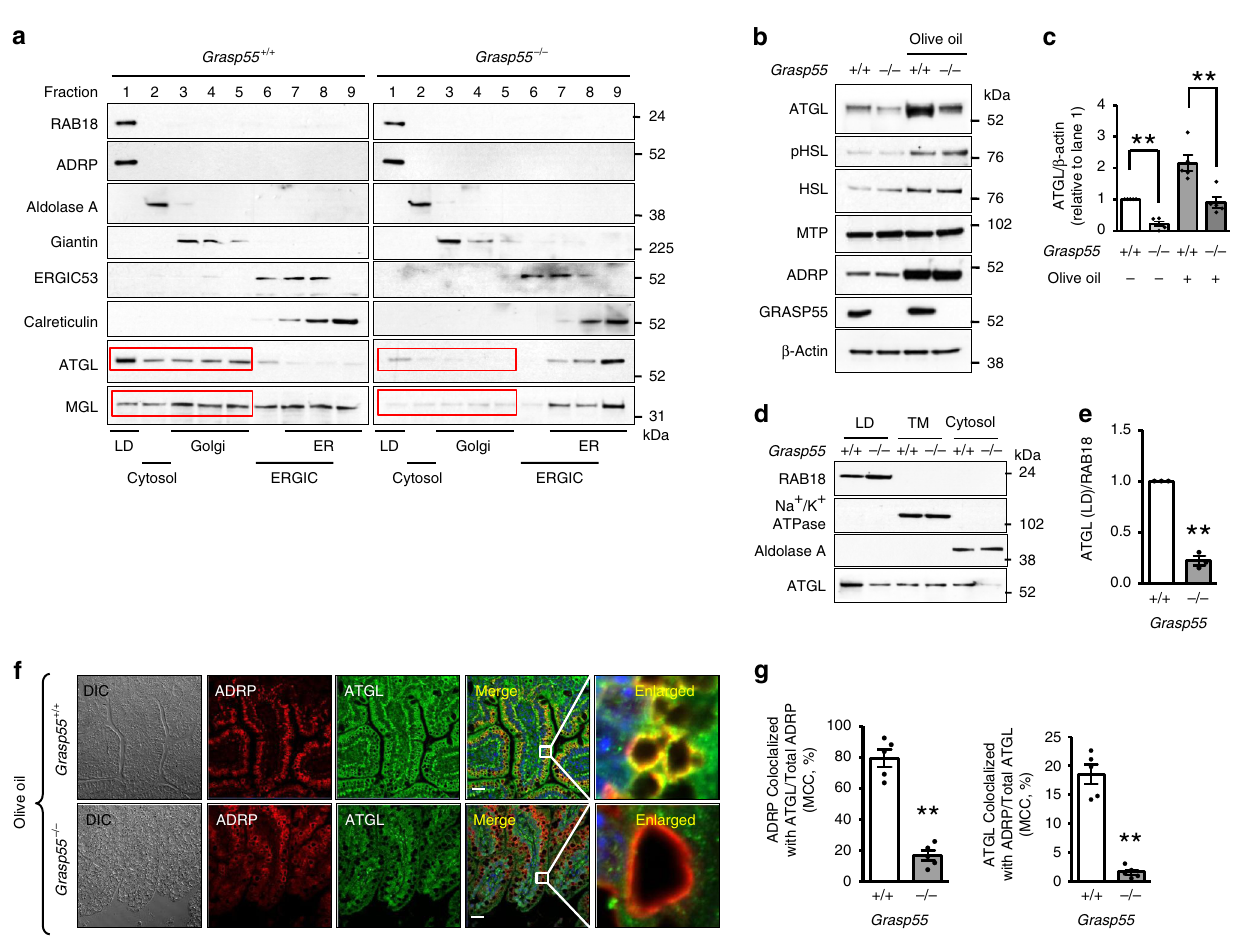
Fig. 5 GRASP55 participates in the Golgi localization and LD targeting of ATGL and MGL. a Subcellular localization of ATGL and MGL in the intestinal epithelial cells of Grasp55 + / + and Grasp55 − / − mice was determined using LD fl oating ultracentrifugation (for Fraction 1), followed by subcellular fractionation assay (for Fractions 2 – 9; using pooled jejunum tissue from four male mice 4 h after olive oil bolus [olive oil, 10 μ l g − 1 of body weight]) as described in Methods. RAB18/ADRP, Aldolase A, Giantin, ERGIC53, and calreticulin were used as organelle markers of the LDs, cytosol, Golgi, the ER-Golgi intermediate compartment (ERGIC), and the ER, respectively. Immunoblotting results with a full list of proteins involved in lipid metabolism are shown in the Supplementary Fig. 8. The Golgi localizations of ATGL and MGL were reduced by GRASP55 de fi ciency in mouse intestinal cells (red boxes). Three independent experiments showed similar results. b , c The protein expressions of ATGL, phospho-HSL (pHSL), HSL, MTP, and ADRP were analyzed by immunoblotting. Jejunum tissues were prepared from Grasp55 + / + and Grasp55 − / − mice fasted for 16 or 4 h after olive oil bolus (olive oil, 10 μ l g − 1 body weight). Representative immunoblots are shown in ( b ). Densitometric analysis of ATGL are shown in ( c , n = 5). A summary of pHSL, HSL, MTP, and ADRP is shown in Supplementary Fig. 11a – d. The level of β -actin was monitored as a cytosolic protein loading control. d , e Measurements of ATGL in the lipid droplet (LD) fraction of intestinal epithelial cells (using pooled jejunum tissue from four male mice 4 h after olive oil bolus [olive oil, 10 μ l g − 1 of body weight]). Representative immunoblots are shown in ( d ) and a summary of multiple experiments is shown in ( e , n = 3). TM, total membrane. f , g Intracellular localization of ATGL and ADRP, a marker protein of LD, in jejunal epithelia of mice 4 h after olive oil bolus. Representative images are shown in ( f ) and quantitative analyses of colocalization between ATGL and ADRP are presented in ( g , n = 5). MCC, Manders ’ colocalization coef fi cient. Unprocessed blots can be found in Supplementary Fig. 22. Data are shown as mean ± SEM. Scale bars: 20 μ m. ** p < 0.01. P values were calculated